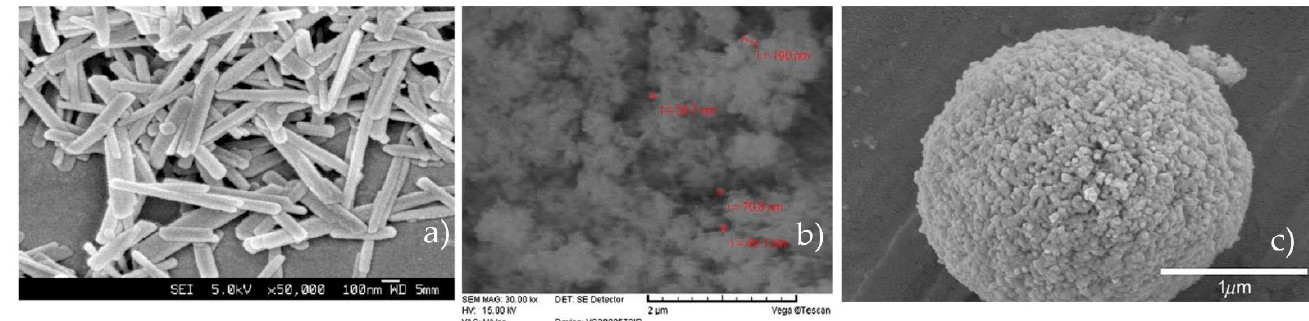
Figure 1. ( a ) FTIR spectra of HAP. Reproduced with permission from [30], Elsevier, 2014. ( b ) FTIR spectra of Si-substituted HAP. Reproduced with permission from [31], Elsevier, 2008.